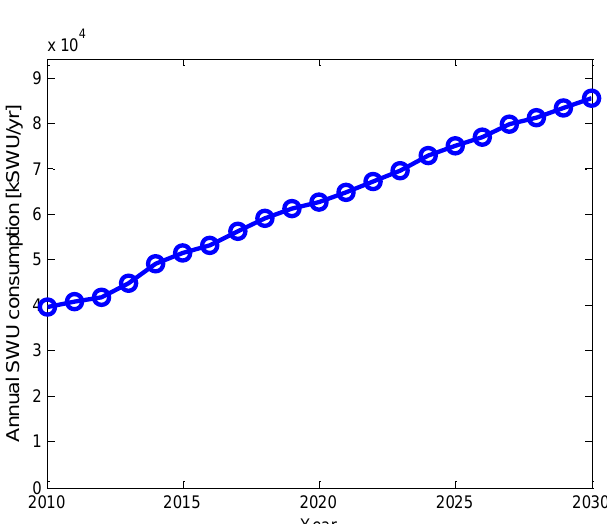
Figure 9. Annual SWU